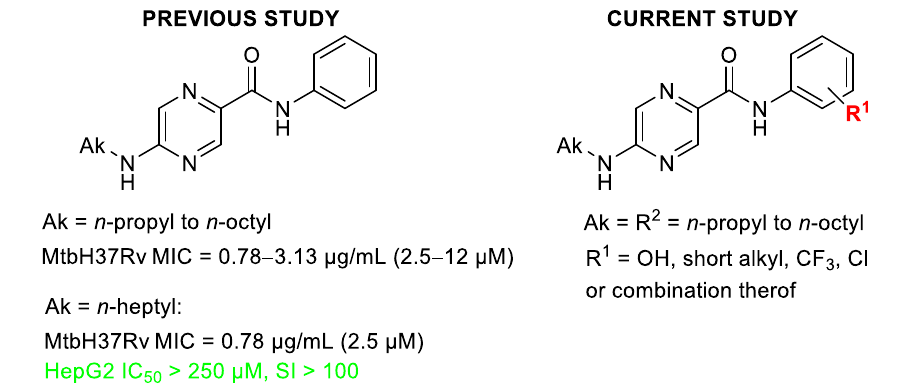
Figure 1. 5-Alkylamino- N -phenylpyrazine-2-carboxamides [14] as a starting point for this study.